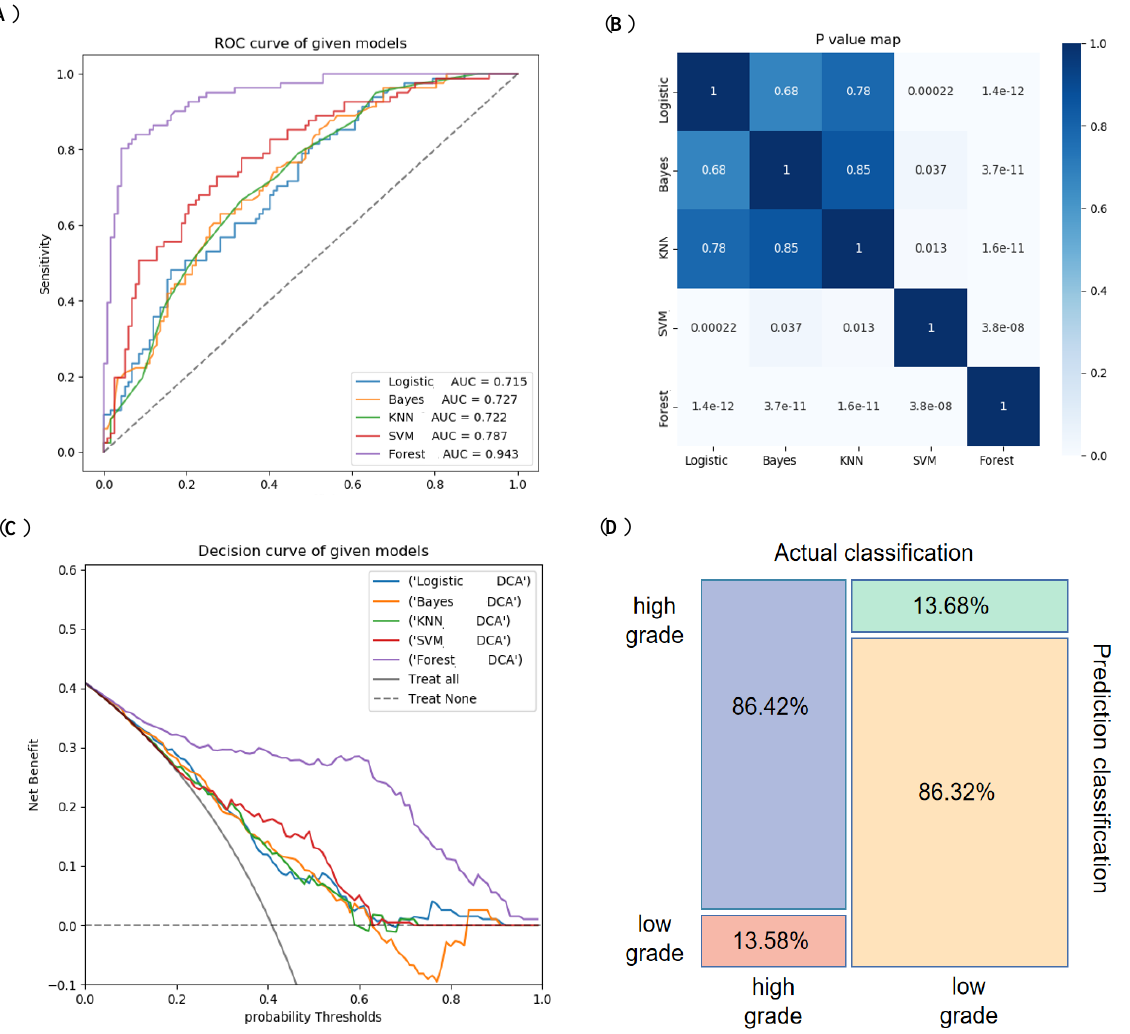
Figure 6. The performance evaluation of the five radiomics models in internal training group. ( A ) The RF model had the maximum AUC, followed by SVM, Bayes, KNN and LR. ( B ) DeLong test showed the AUC of RF model was significantly different than that of other models, followed by SVM model. ( C ) The decision curves show that the RF model had greatest net benefit with a threshold probability > 0.06. ( D ) Mosaic map showed the RF model achieved 86.42% and 86.32% predictive accuracy in the high-grade and the low-grade group, respectively.